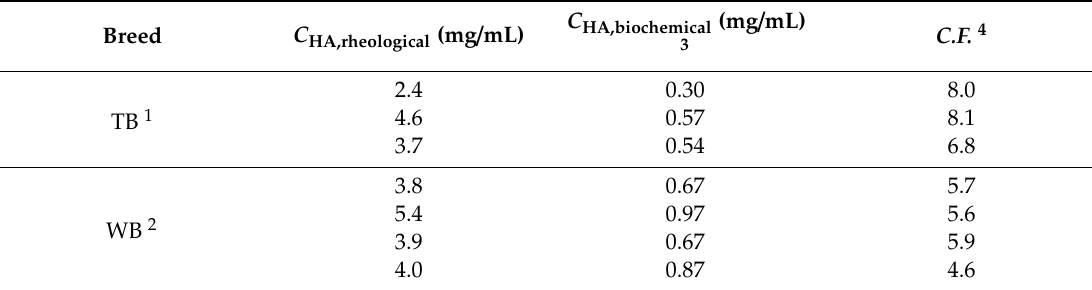
Table 4. HA concentration in SF from healthy equine fetlock joints, as calculated either based on SF rheological data or by employing the biochemical ELISA method.